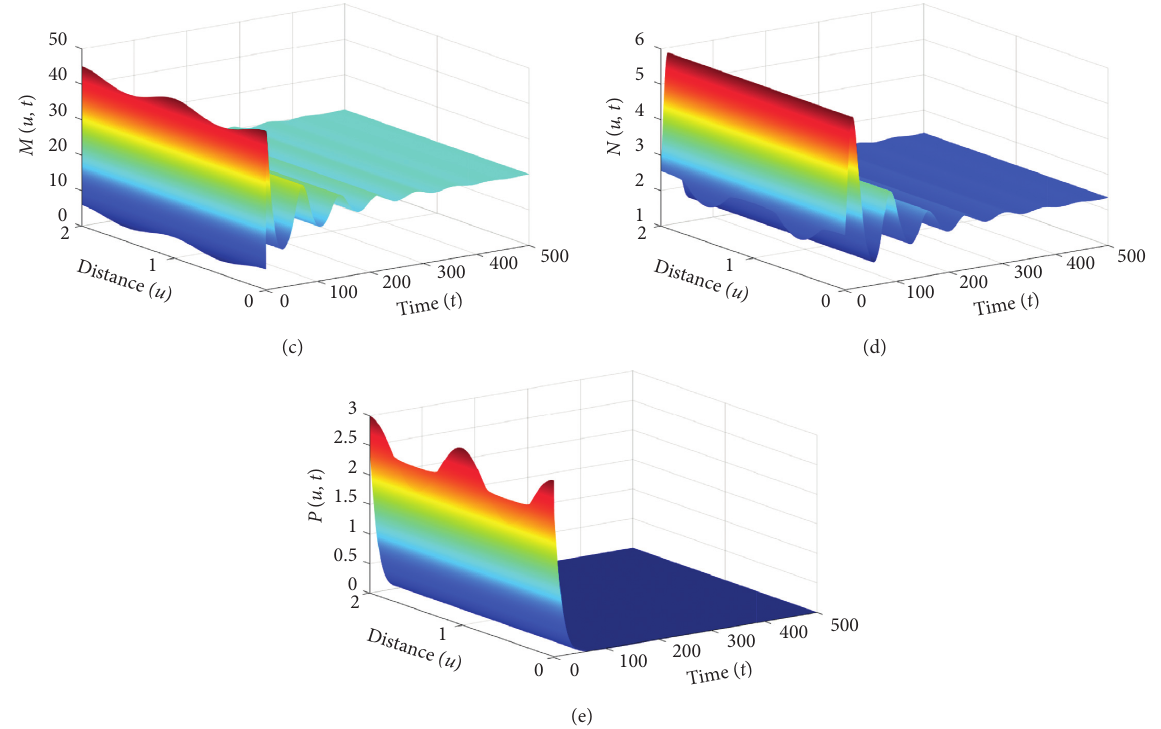
� ( 555 . 556 , 14 . 815 , 20 , 2 . 346 , 0 ) is asymptotically stable. (a) Target > 1 and R ≤ R ), the equilibrium Ω 1 2 1 2